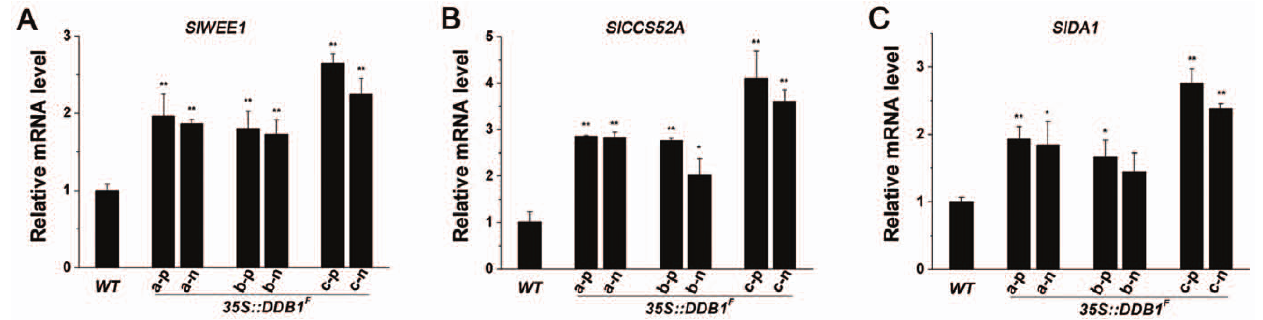
Figure 5. Real-time RT-PCR analysis of mRNA levels of genes regulating cell division in 7-DPA fruits from WT Ailsa Craig ( WT ) and 35S::DDB1 F T 2 transgenic lines (a, b, c). p and n represent plants with or without transgene, respectively. Each bar represents three repetitions from each RNA sample (derived from pools of at least three fruits per plant). Error bars representing standard errors are shown in each case. Statistical analysis was performed using Student’s t -test (*P , 0.05, **P , 0.01). Similar results were obtained in at least two independent experiments.